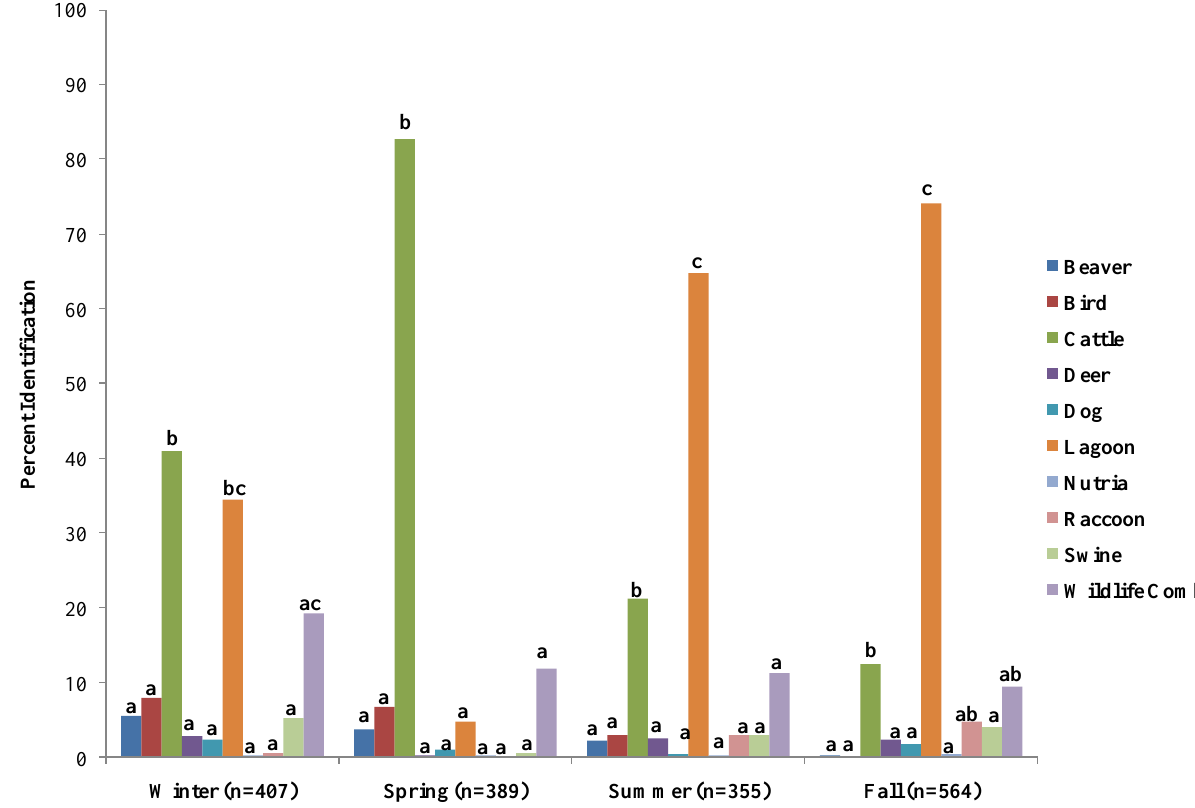
Seasons. Bars within each season category with the same letters are not significantly different (Tukey–Kramer (HSD) test